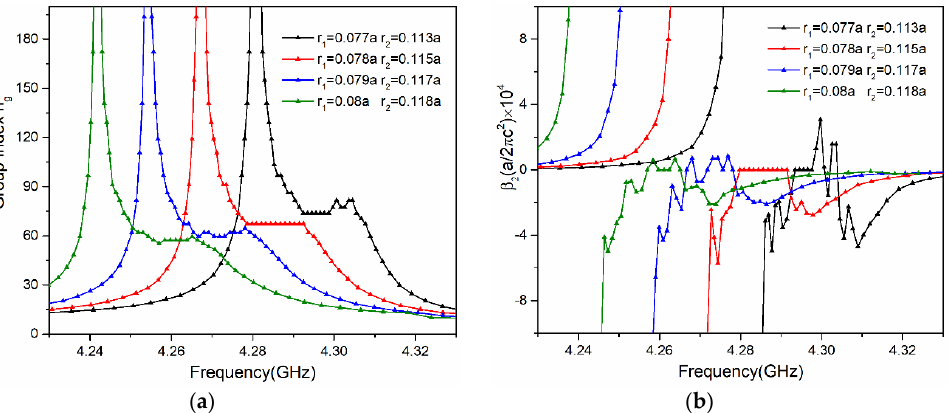
Figure 5. ( a ) Calculated group indices 𝑛 𝑔 and ( b ) the corresponding 𝛽 2 as a function of the frequencies for the four optimized PCWs.